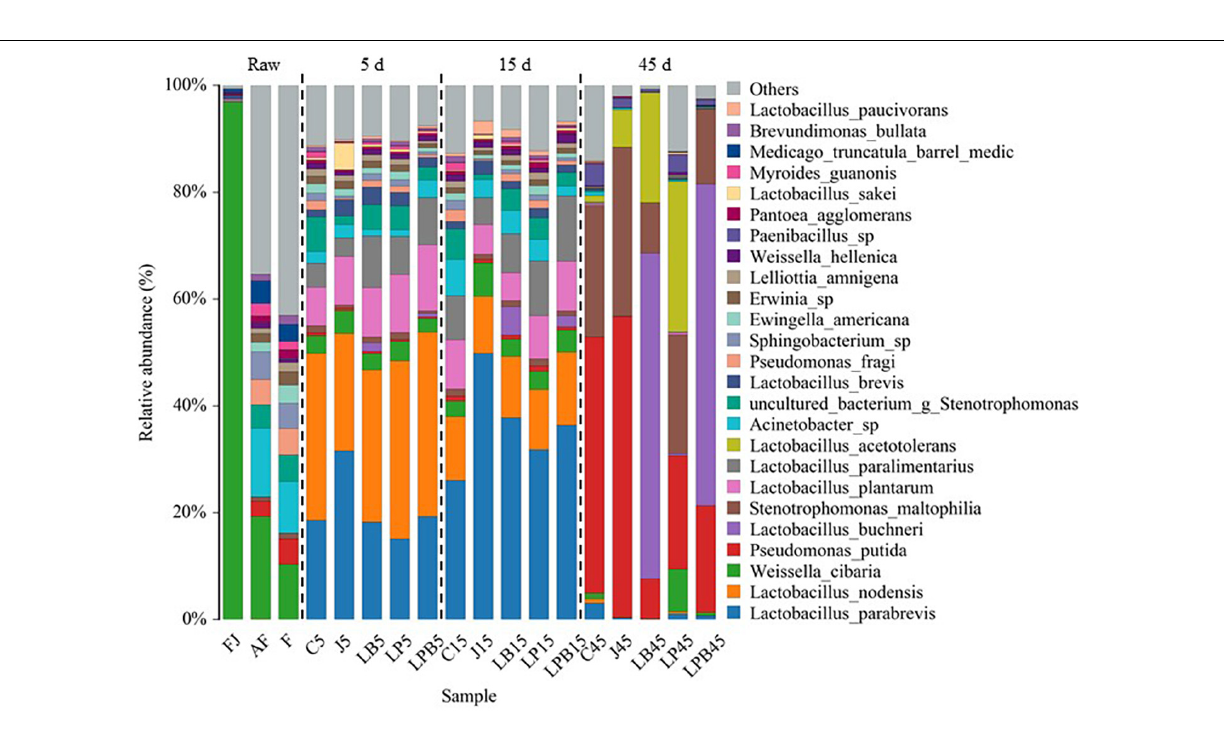
FIGURE 4 | Bacterial community (species level) of mixed silage. AF, fresh lucerne; FJ, pre-fermented juice; F, mixture; C, control; J, pre-fermented juice-treated silage; LP, L. plantarum -treated silage; LB, L. buchneri -treated silage; LPB, L. plantarum L. buchneri- treated silage.